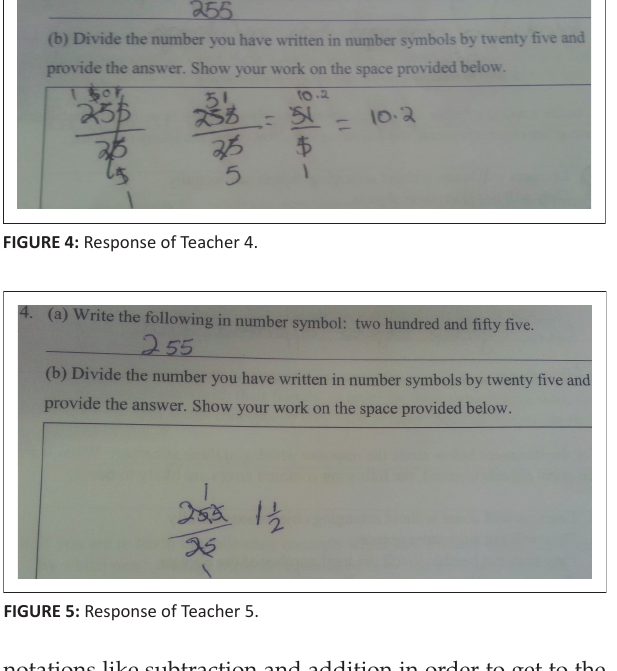
FIGURE 6: Response of Teacher 6.